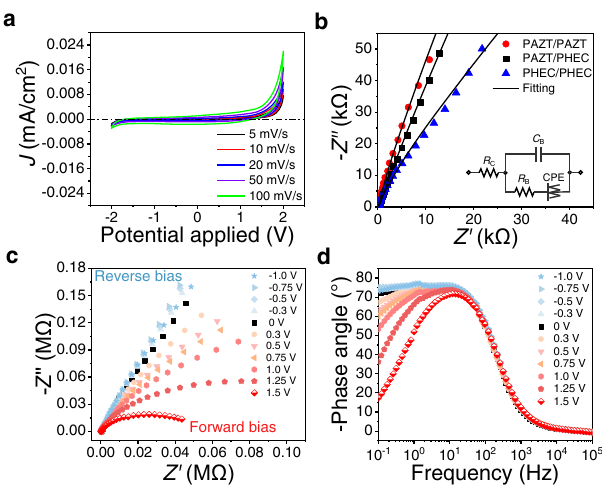
Fig. 4 | Electrochemical analysis of GPE ionic diode. a CV plots for PAZT/PHEC scanned from – 2V to + 2V at various scan rates; b Nyquist plots for PHEC/PHEC, PAZT/PAZT and PHEC/PAZT; c Nyquist plot of PAZT/PHEC heterojunction mea- sured under dc biases; d Bode phase plot of PAZT/PHEC heterojunction measured under dc